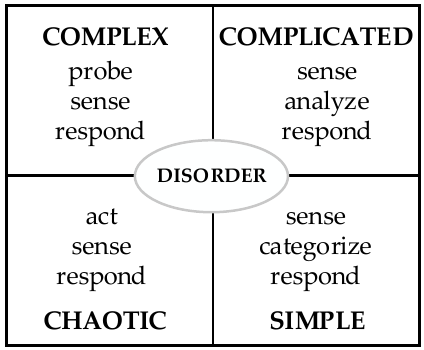
Figure 1. Cynefin Framework.